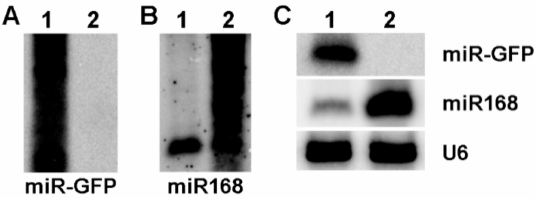
Figure 4. The expression of amiRNAs in maize protoplasts. ( A ) The expression of miR-GFP based on the precursor of ath-miR319a as backbone. ( B ) The expression of miR168 based on the precursor of ath-miR319a as backbone. ( C ) The expression of amiR-GFP and miR168 based on the precursor of osa-miR528a as backbone. U6 was used as a loading control. 1: The expression of miR-GFP; 2: The expression of